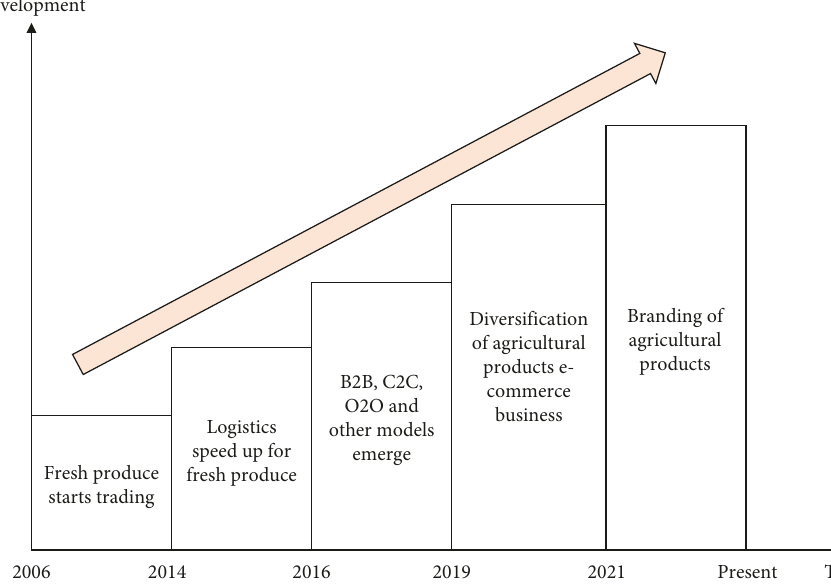
Figure 1: Process of rural e-commerce development in China.